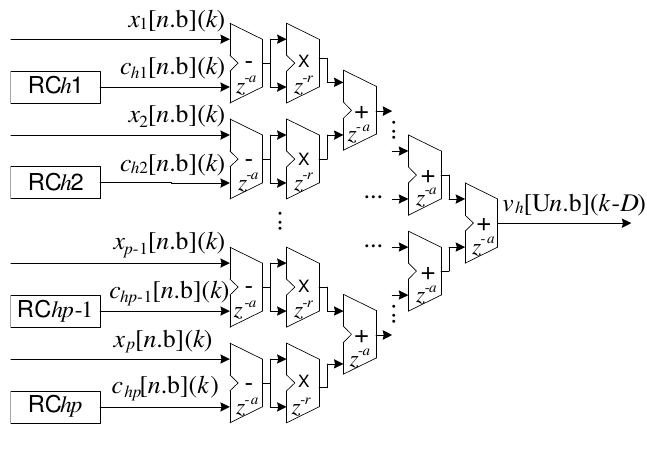
Figure 3. The implementation as described in Equations (2) and (5).